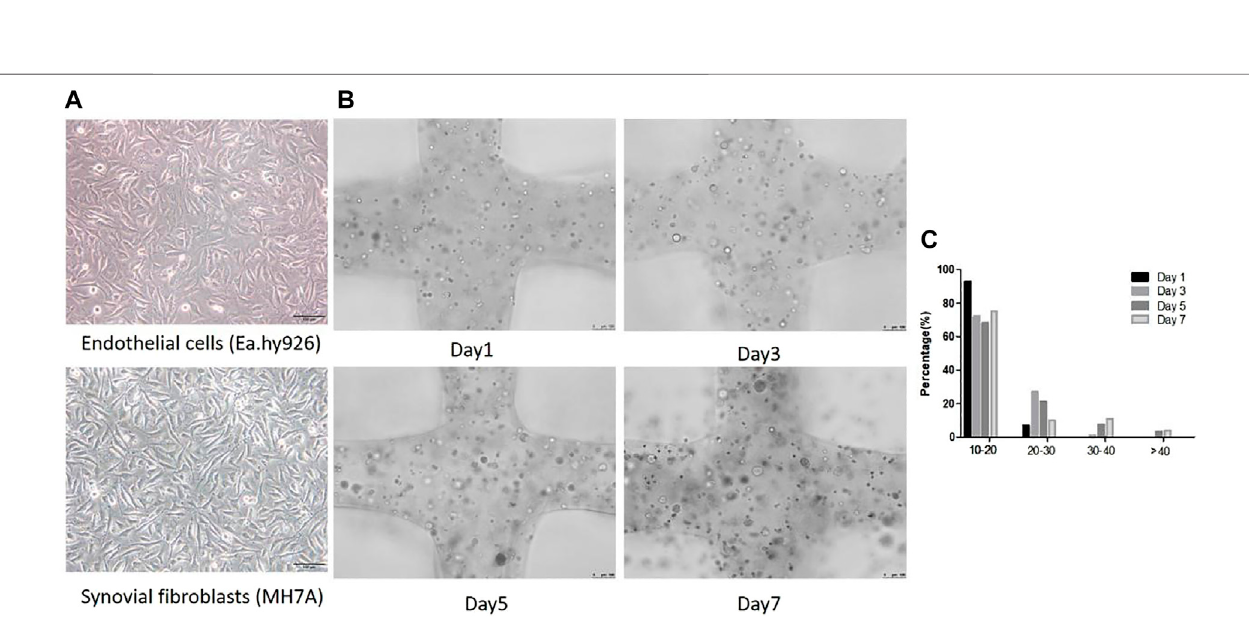
Frontiers in Bioengineering and Biotechnology |